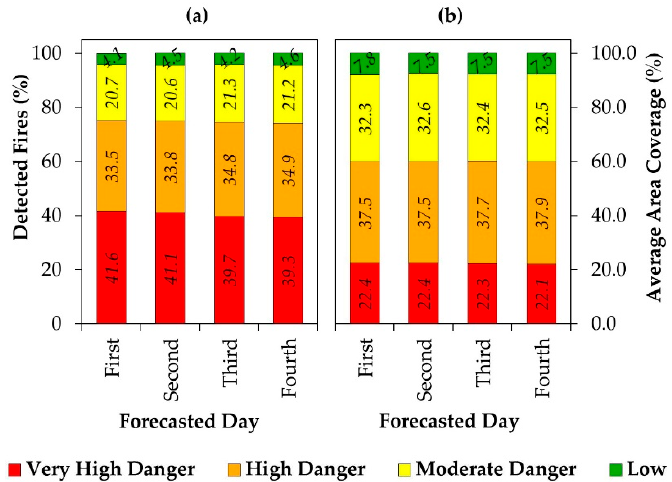
Figure 4. The performance of the RS-based four-day scale FFDFS model against the historical forest fire occurrences during the 2015–2017 period in terms of the matching of the detected fires with the four FD classes in the final forecasted FD maps ( a ); and the average area covered by each of the FD classes ( b ). found to be about 74.68% in this study, which was higher than the reported accuracy (i.e., about